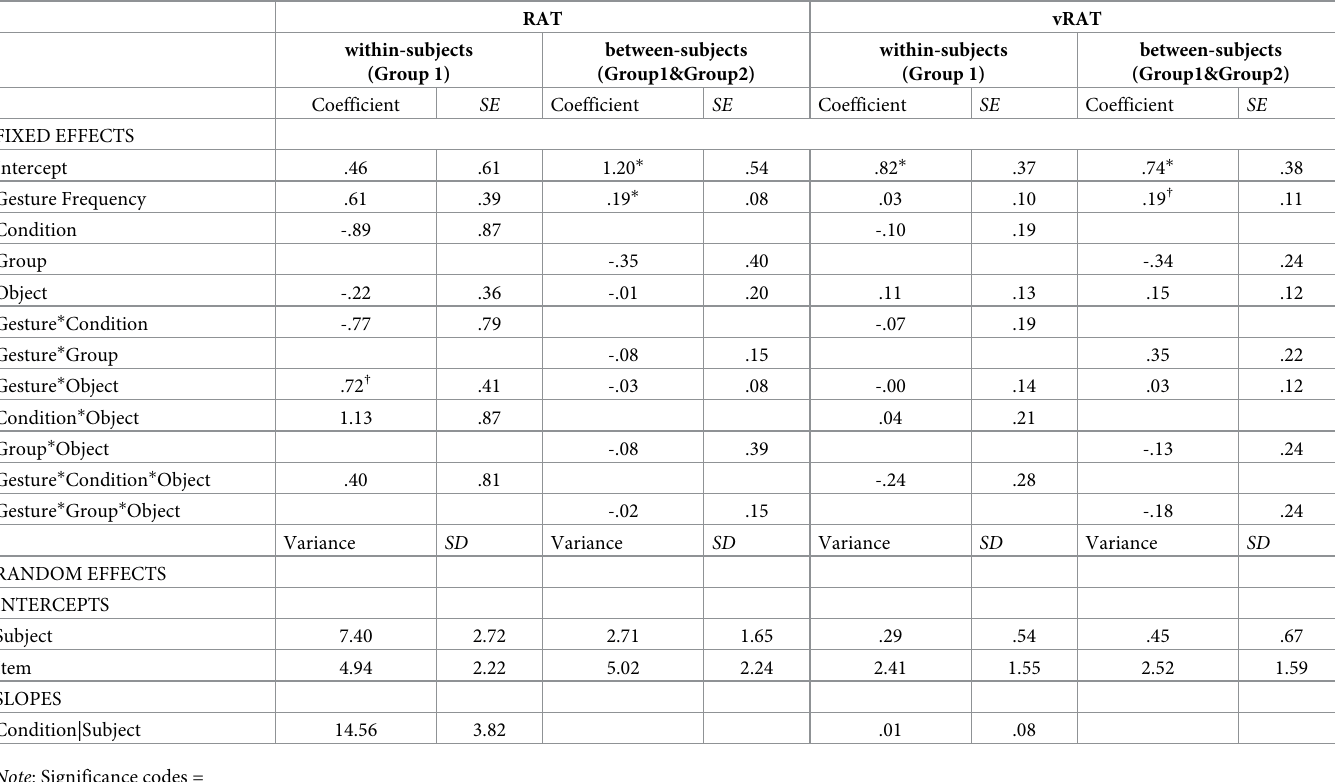
Table 9. Model summary for object